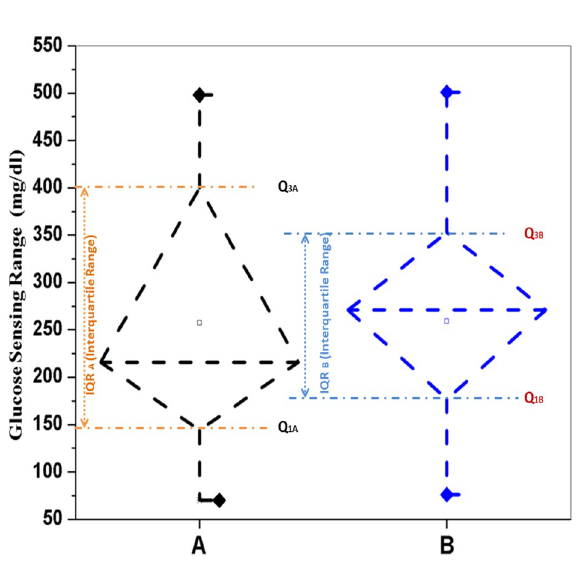
Figure 6. Glucose measured by (A) Accu-ckeck Aviva commercial glucose meter ( 259.23 ± 109.37mg/dl ) and (B) Proposed glucose meter ( 257.23 ± 131.33mg/dl ) (no statistically difference with p > 0.05